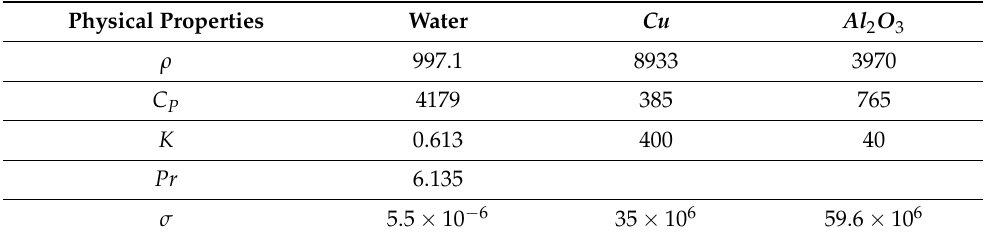
Table 1. Thermal properties of Cu , Al 2 O 3 , and water.